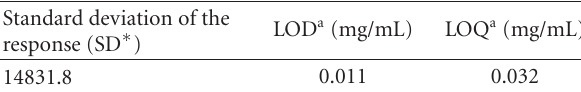
Table 4: Limits of detection (LOD) and quantitation (LOQ) of the HPLC method for the determination of hederacoside C in Ivy- Thyme cough